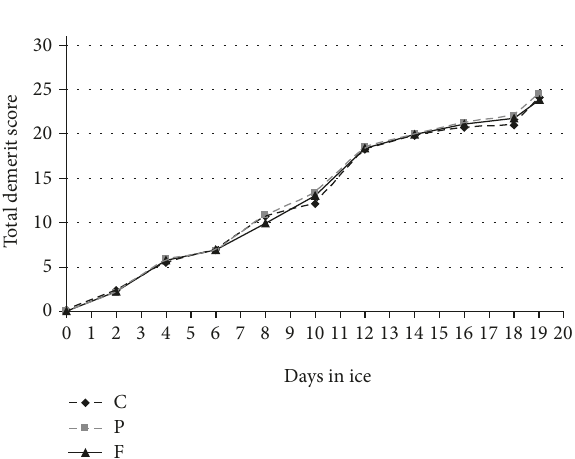
Figure 5: QIM freshness sensory scores for the three common carp groups (C: control diet; F: fish meal/fish oil diet; P: plant-based diet) stored in